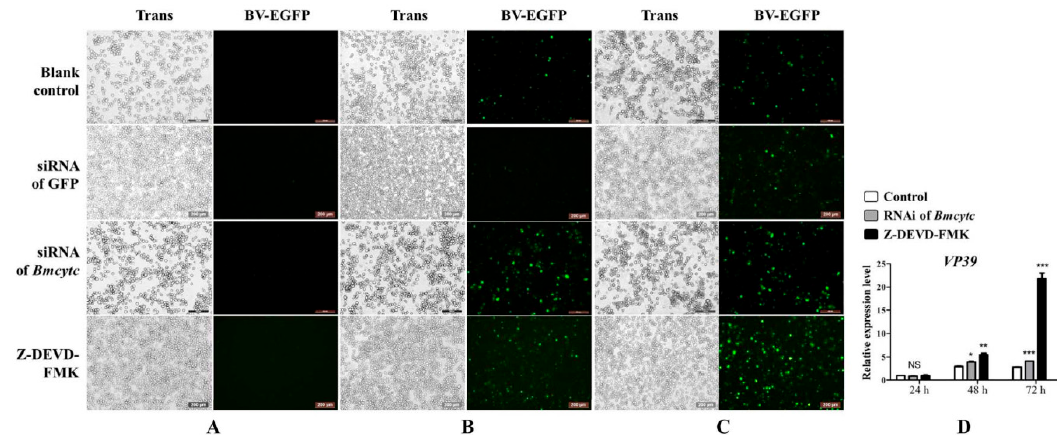
Figure 4. Analysis of BmNPV infection in BmN cells following knockdown of Bmcytc at di ff erent times. ( A ) 24 h after BV-EGFP infection. ( B ) 48 h after BV-EGFP infection. ( C ) 72 h after BV-EGFP infection. ( D ) The expression analysis of vp39 after knockdown of Bmcytc at di ff erent times. Scale bar = 200 µ m. Trans (white), optical transmission. EGFP (Green), expressed following the replication of BV.